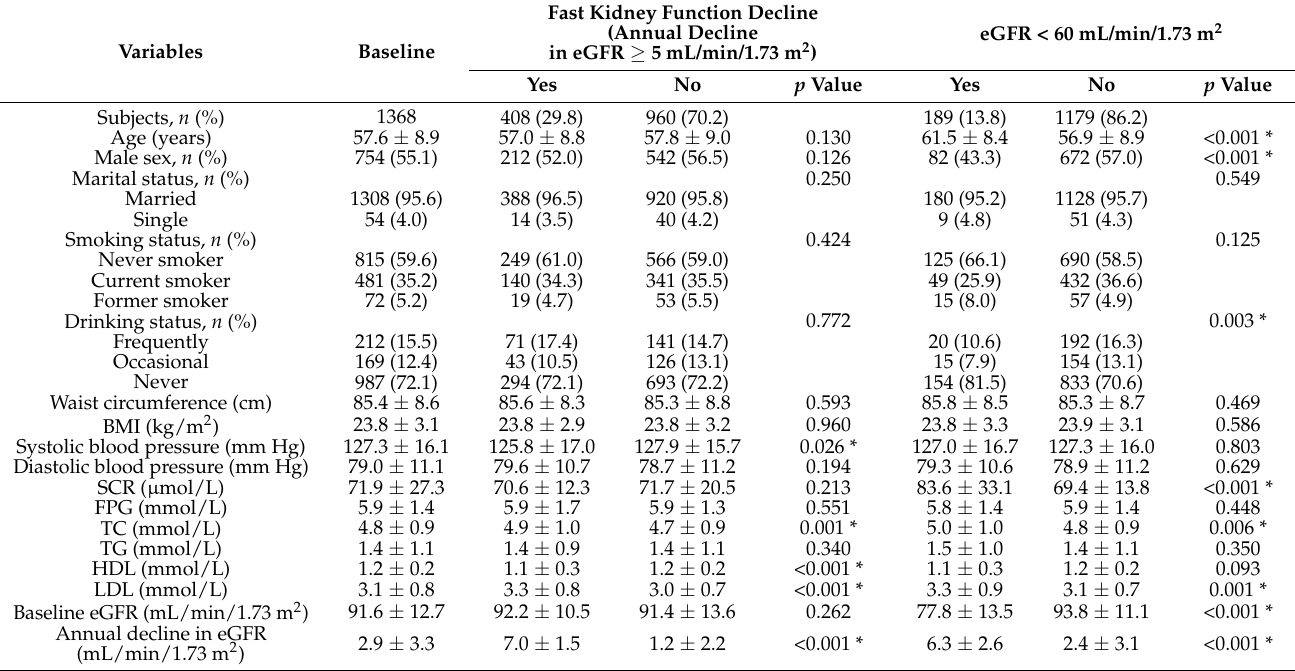
Table 1. Initial characteristics of the study population ( n = 1368).